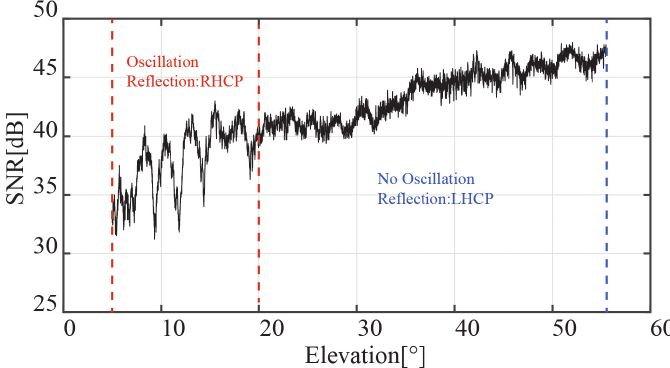
Figure 5. The SNR of GPS PRN2 when the corn is lower than the GNSS antenna.